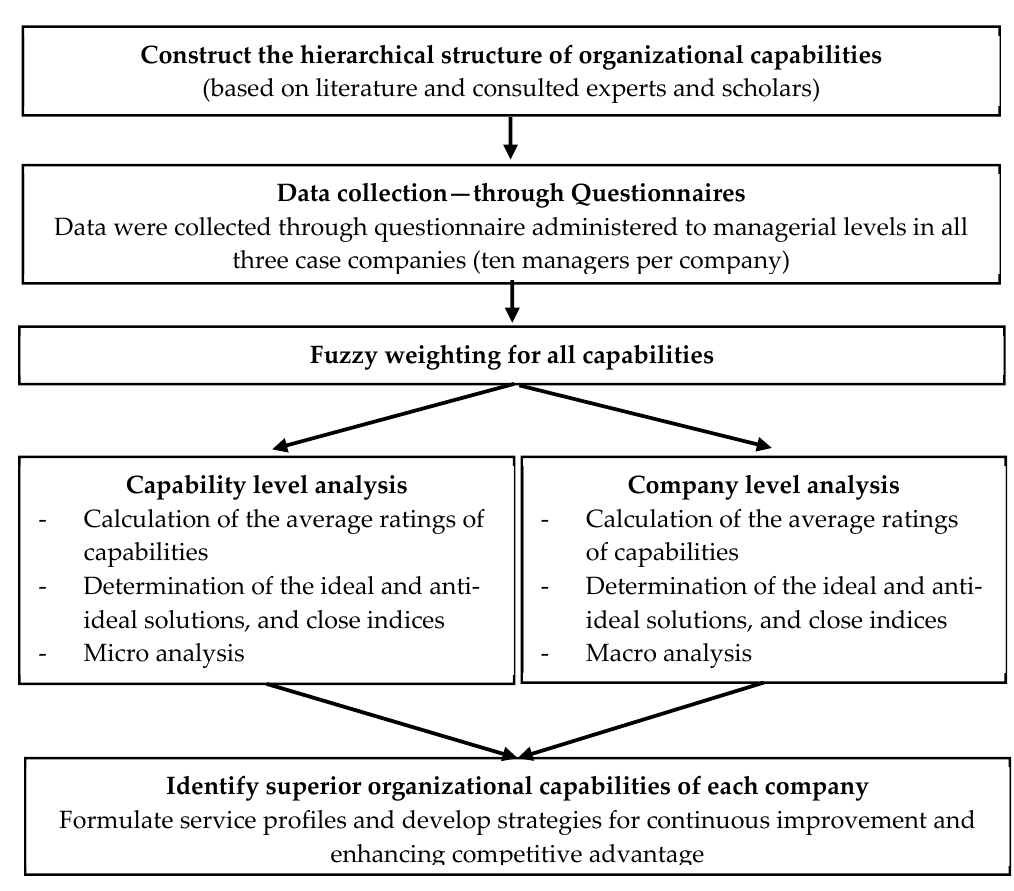
Figure 1. Flowchart of empirical study.